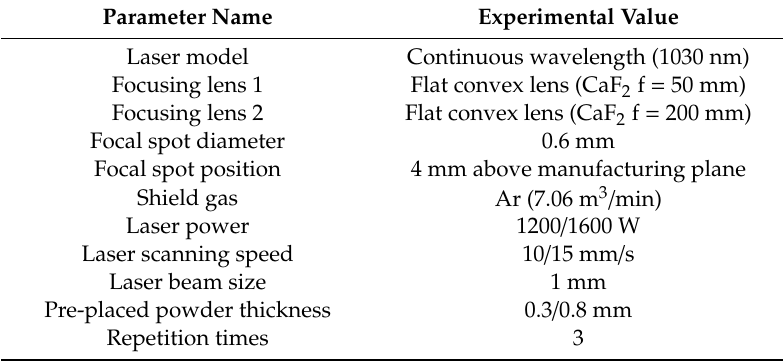
Table 3. Fabrication parameters of laser cladding